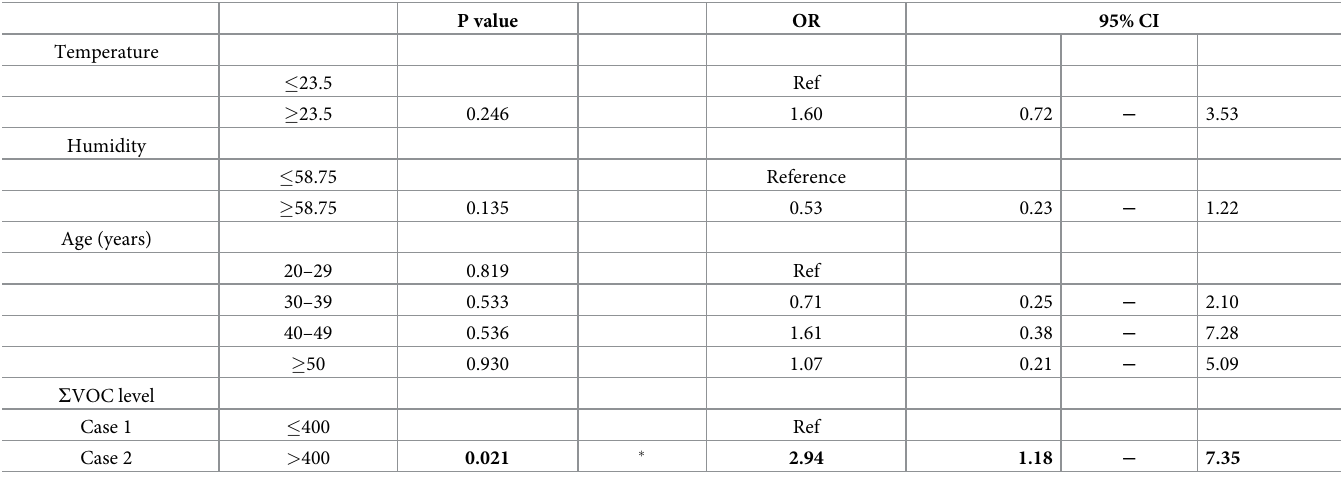
Table 2. Logistic regression analysis of personal and environmental factors and occurrence of